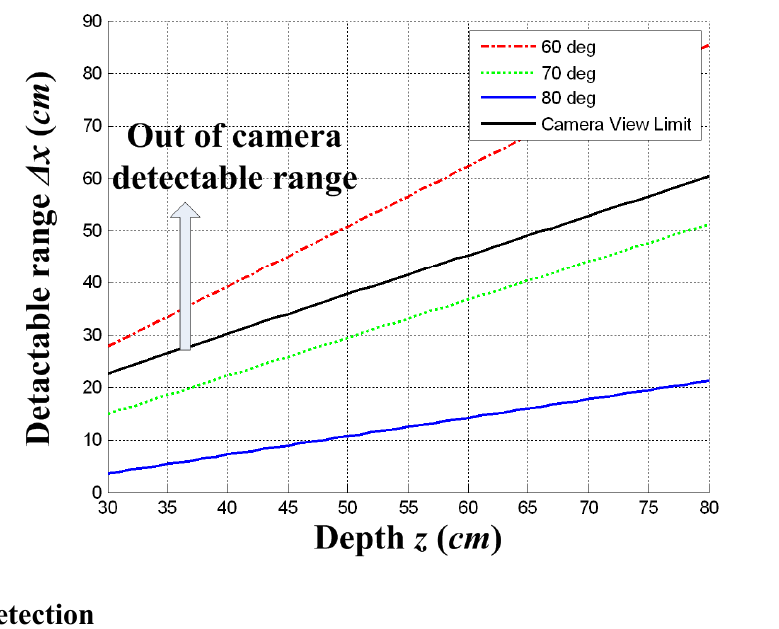
axis according to the depth z c